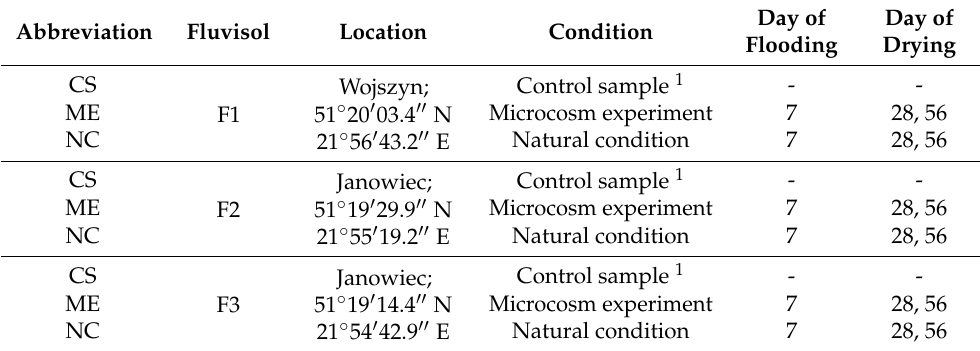
Table 1. Samples used in the experiment—abbreviations, location,